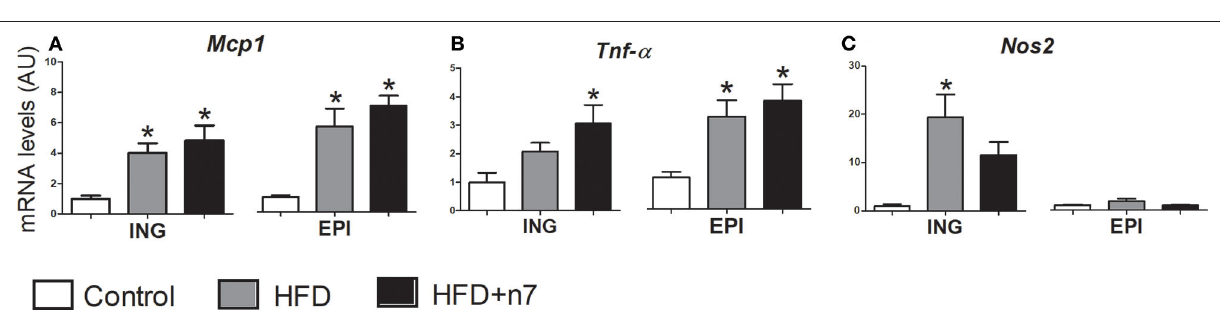
FIGURE 5 | mRNA levels of Mcp1 (A) , Tnf- α (B) , and Nos2 (C) expressed by isolated adipocytes from ING and EPI fat depots in arbitrary units (AU), normalized by Gapdh . Results were expressed as mean ± SEM ( n = 12). Data were analyzed by one-way ANOVA. * p < 0.05 vs.